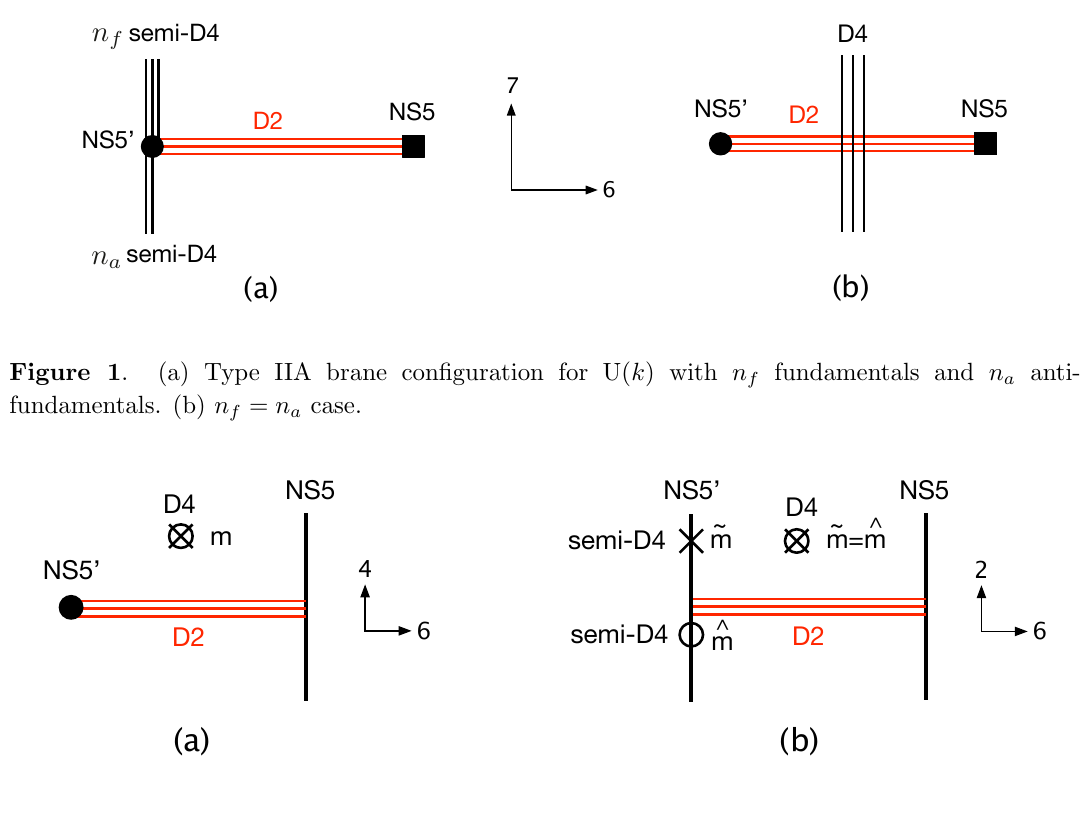
fundamentals and n f